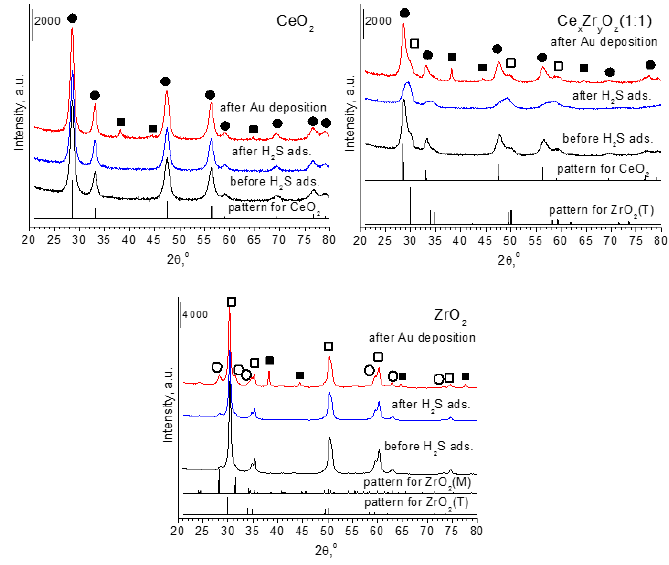
Figure 1. X-ray Diffraction (XRD) patterns of selected samples before and after H 2 S adsorption and after Au deposition, where ■ —means the crystal phase of metallic gold particles, ● —cubic crystal phase of ceria (pattern for CeO 2 ), □ —tetragonal crystal phase of zirconia (pattern for ZrO 2 (T)) and ○ —monoclinic crystal phase of zirconia (pattern for ZrO 2 (M)).